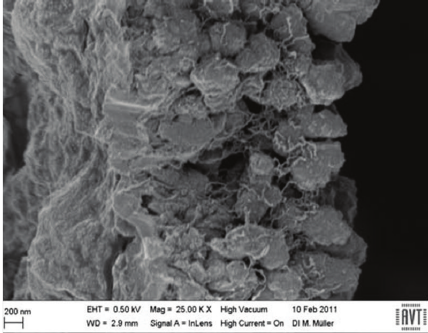
Figure2:SEMImageofthinfoilofthecopper-CNTcomposite[34].